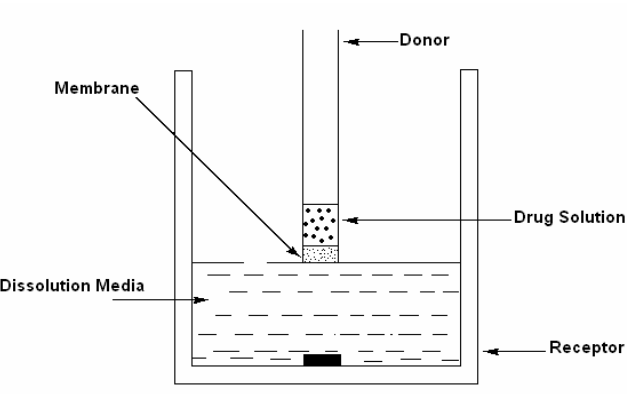
Figure 1. Diaphragm cell used to measure diffusion coefficient (D)